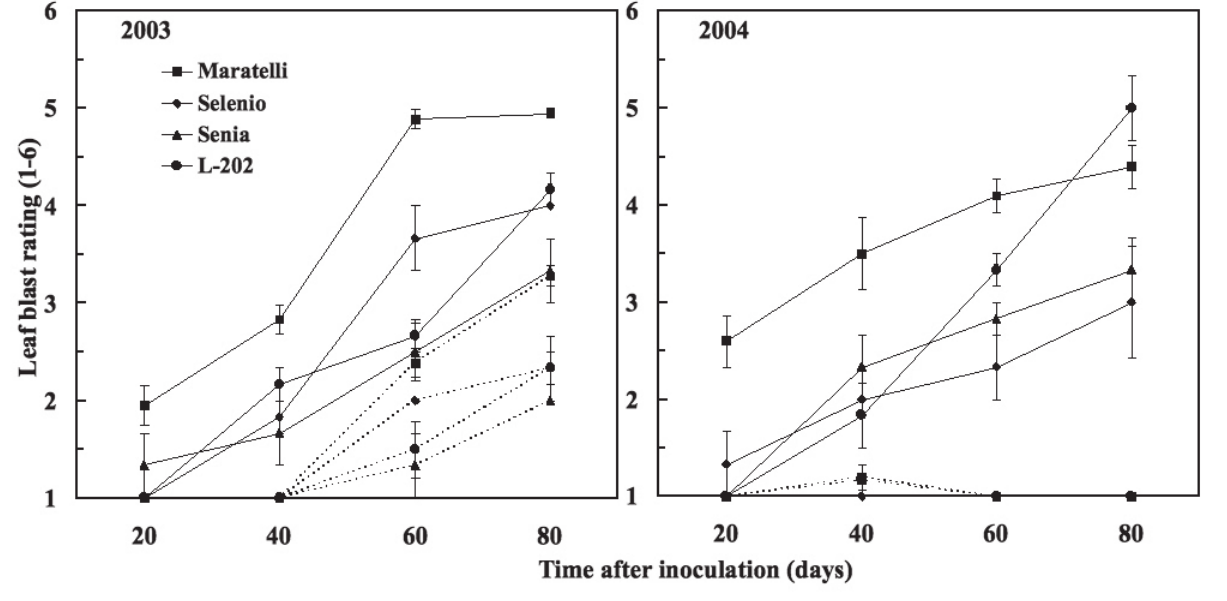
Fig. 1. Ratings of leaf blast from Magnaporthe grisea in four rice varieties, inoculated (solid lines) and non-inoculated (dotted lines) with the fungus in field experiments conducted in 2003 and 2004. Leaf blast was assessed 20, 40, 60 and 80 days after inoculation. Vertical bars show the mean standard